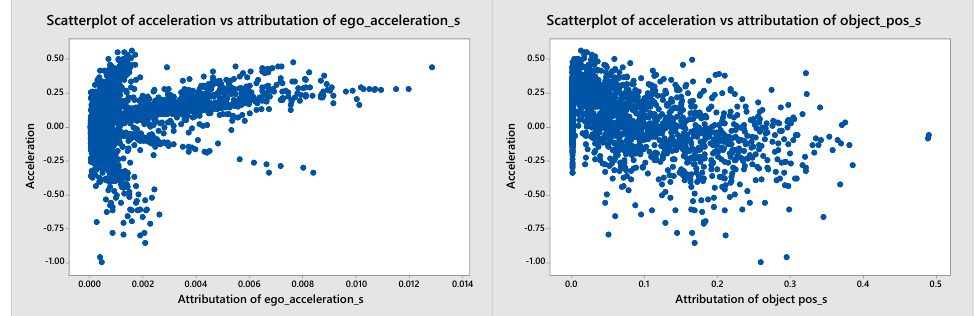
Figure 5. Scatterplot present the correlation between acceleration of continuous agent and attributa- tion of its acceleration value and position of other